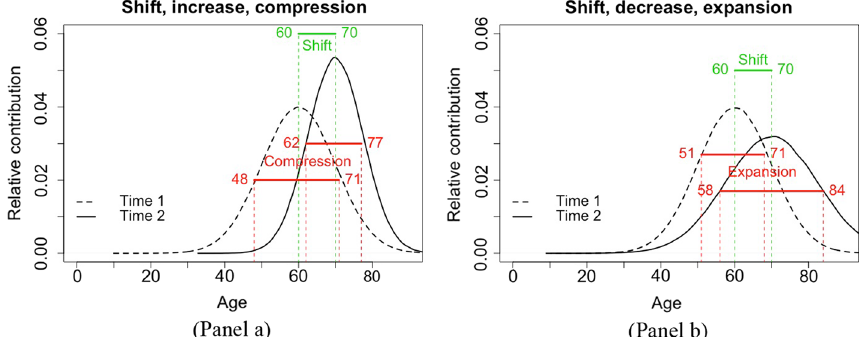
Fig. 1 Patterns of distribution of relative age-specific contributions to the sex gap in life expectancy over time. Panel a : shift, increase, compression; Panel b : shift, decrease,